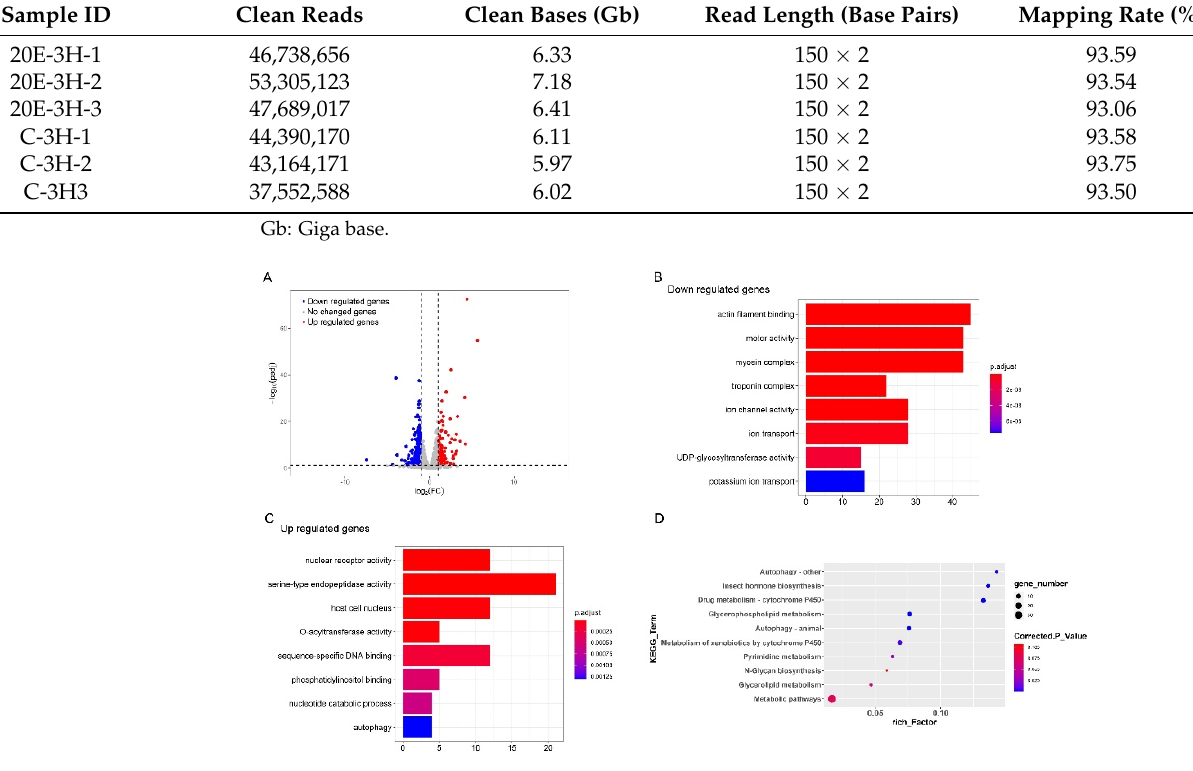
Figure 2. Comparative transcriptome analysis of the larvae midgut treated with 20E or 20% ethanol. ( A ) Volcano plot of the differently expressed genes in the midgut of S. litura . The dotted lines indicate thresholds set for regulation (log2 (FC) < − 1 and log2 (FC) > 1) and the significance ( t -test p -value < 0.05). Significantly up-regulated genes in 20E treated larvae midgut are indicated in red spots whereas significantly down-regulated genes are marked in blue. ( B , C ) Scatterplot of enriched GO terms for up-regulated genes and down-regulated genes, respectively. ( D ) KEGG pathway enrichment analysis of the differently expressed genes. Table 2. The expression levels of transcription factors in midgut of S. litura